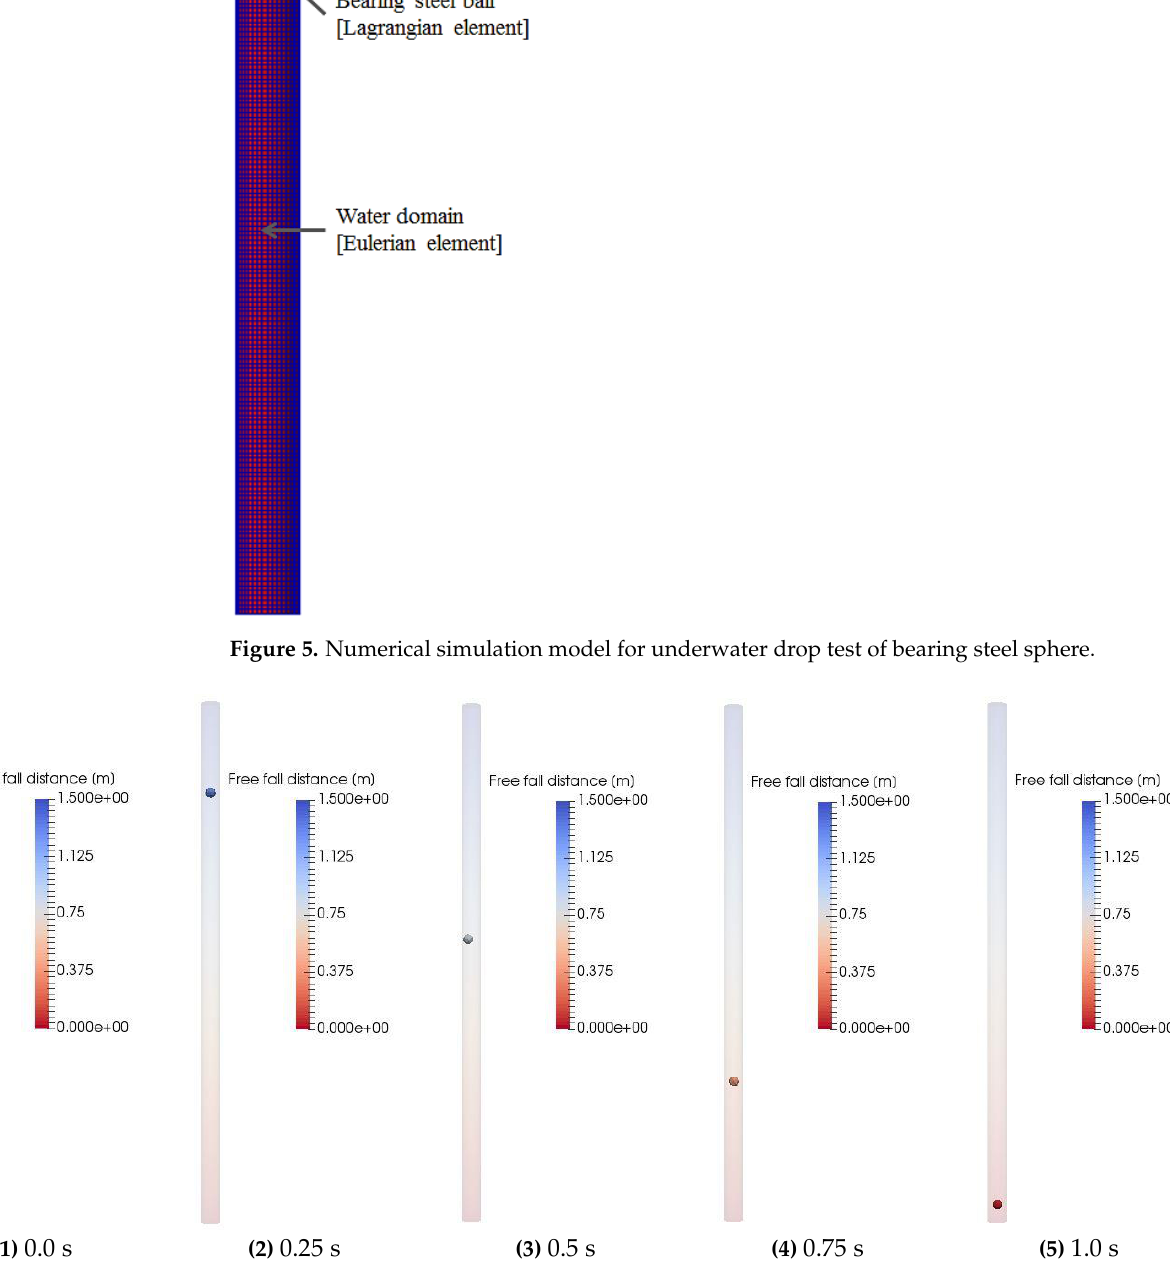
Figure 6. Numerical simulation results for underwater drop test of bearing steel sphere.